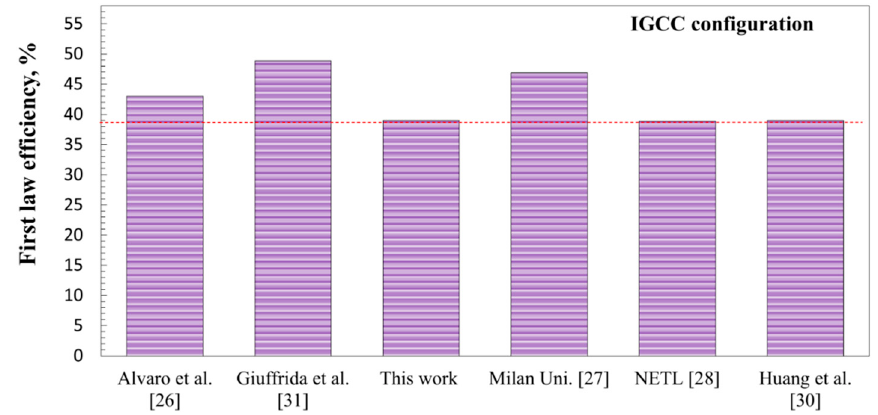
Figure 12. A comparison between the FLE of the IGCC prepared in this work and those publically available [32–34].